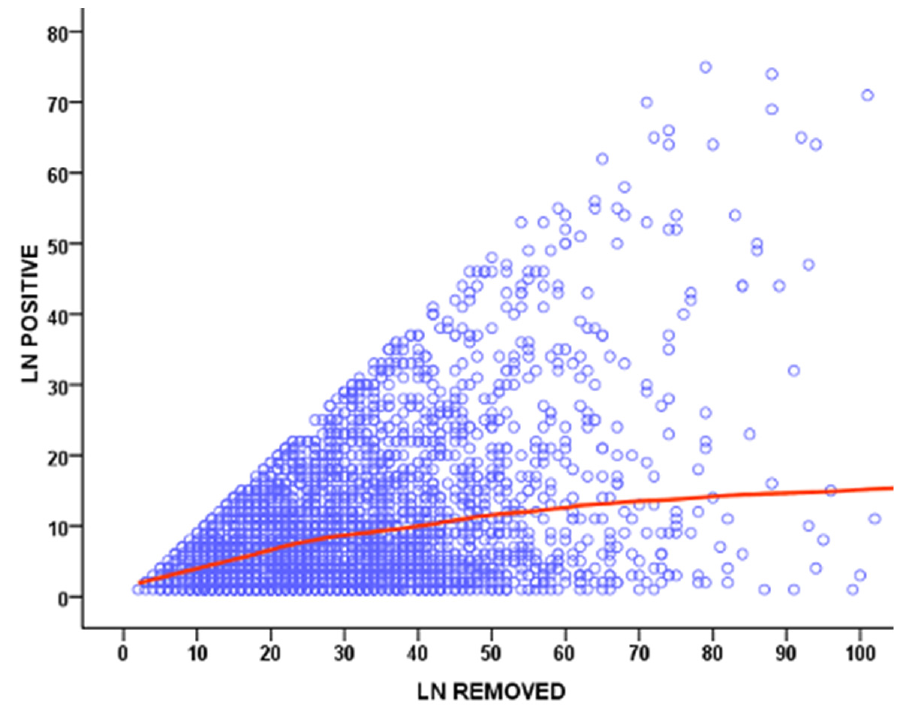
Figure 1. Scatter plot showing the correlation between the number of removed and metastatic lymph nodes (LN) in GIRCG cohort.